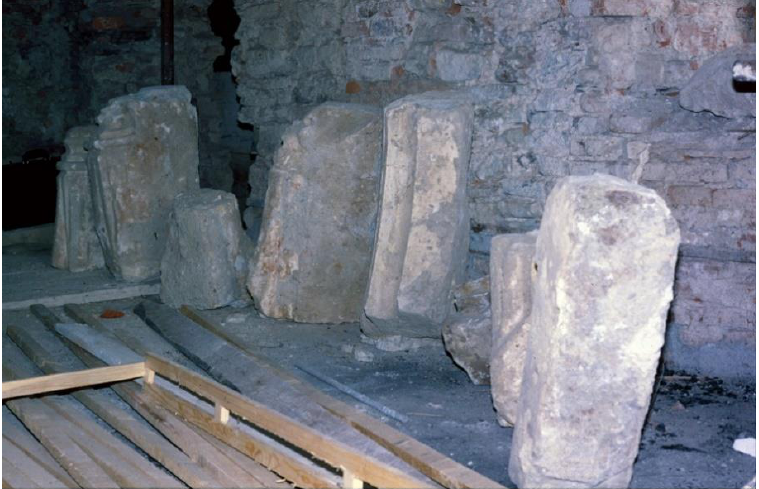
Figure 13. Architectural elements found during excavations. Only few fragments are displayed in situ, others are missing. Interior. Photo: The Maribor Regional Office of the IPCHS, Fond Maribor— Sinagoga.